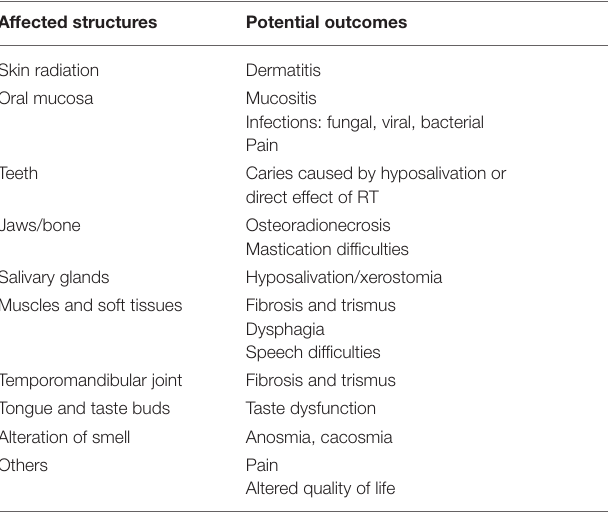
TABLE 1 | Potential outcomes of chemotherapy, radiotherapy and surgery and the affected structures